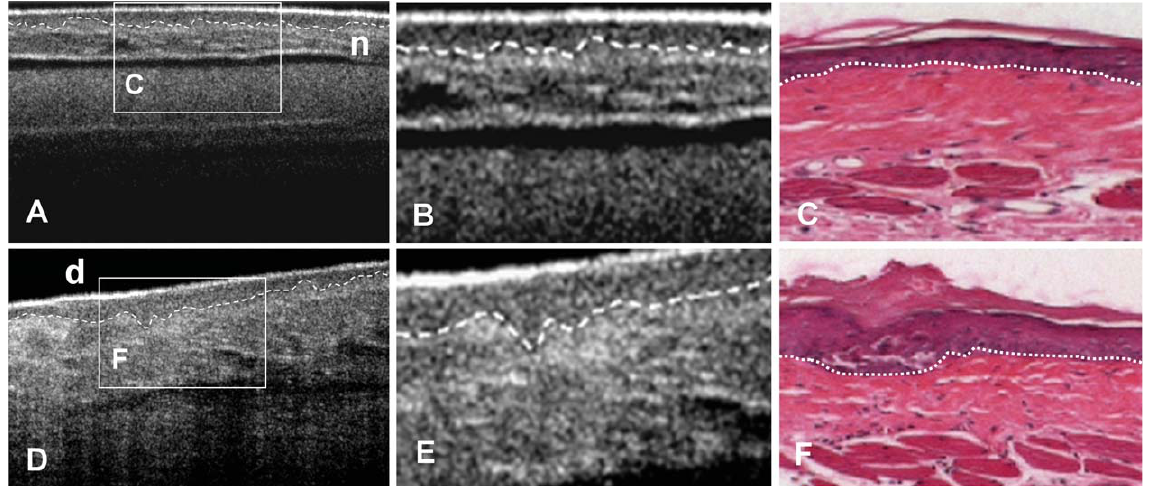
Fig. 5. In vivo OCT images of hamster cheek pouch with dysplasia. (A–C) OCT image of normal hamster cheek pouch and corresponding histology; (D–F) OCT image of hamster cheek pouch with dysplasia and corresponding histology; The OCT images are 2 × 1.3mm with 10 × 10 (cid:1) m display resolution. (B) and (E), higher magnification views of (A) and (D), respectively. The location of the basement membrane is indicated by the dotted lines. Abbreviations: n, normal epithelial and subepithelial layer; d, area of dysplasia with epithelial down growth. Figure used with permission from [55].